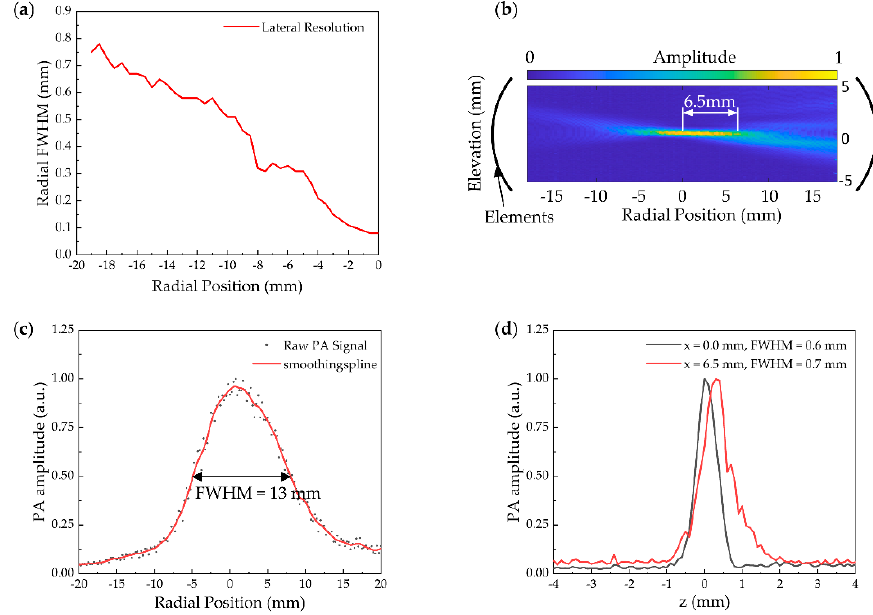
Figure 4. ( a ) Experimental cross-sectional view of the field of view (FOV) with location for a radical cut dividing the transducer into two halves; ( b ) Measured lateral resolution versus distance from the center of the transducer; ( c ) The full width at half maximum (FWHM) of ( a ) the radial FOV focus area; ( d ) The FWHM of ( a ) at the center of the ring-array (x = 0 mm) and at 6.5 mm in the elevation direction.